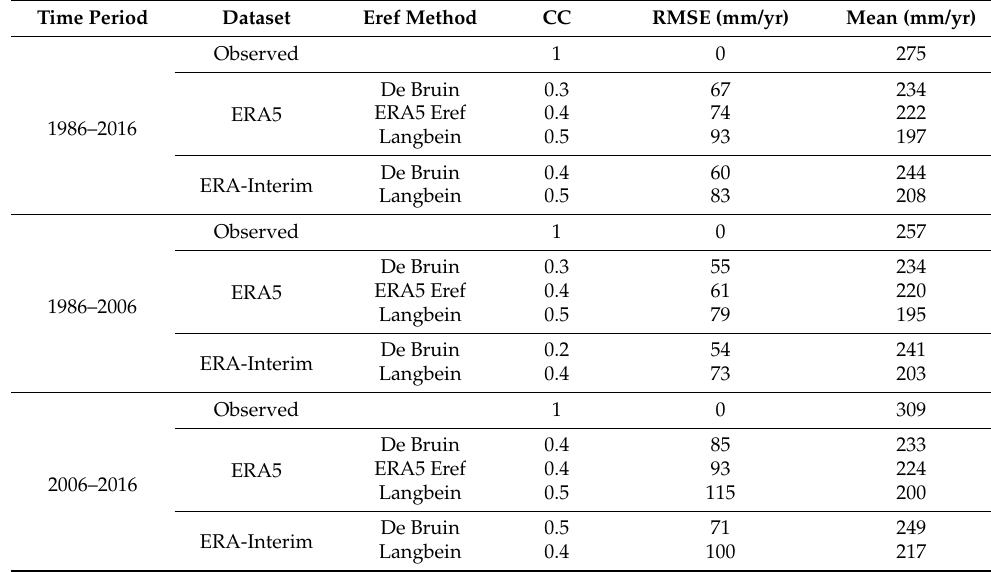
Table 2. Comparisons between calculated actual evaporation (Eact) and water balance-based evaporation. Time